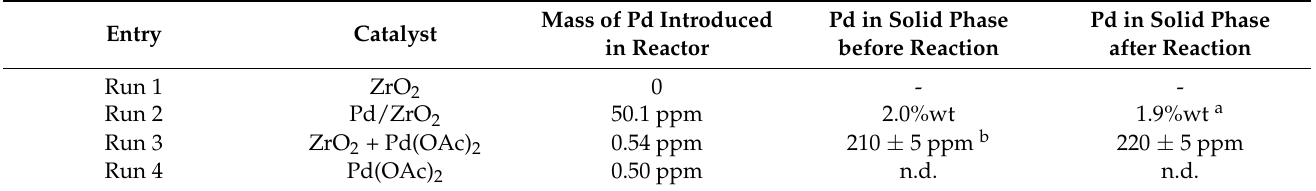
Table 6. Maximum amount of palladium in the reactor, on the support and in